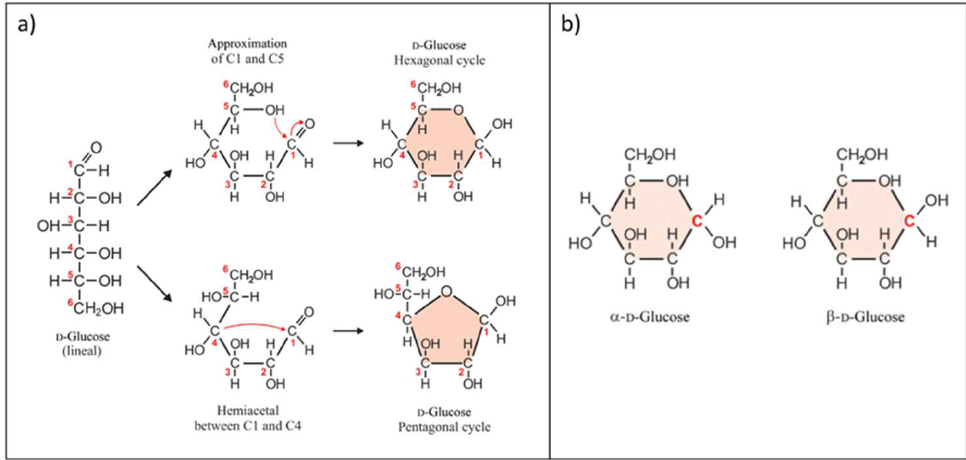
Figure 3. ( a ) Linear form of D-glucose undergoes an intramolecular reaction to form a cyclic hemiacetal; ( b ) different forms of glucose. Reprinted with permission from ref. [85]; Copyright 2017 Elsevier.